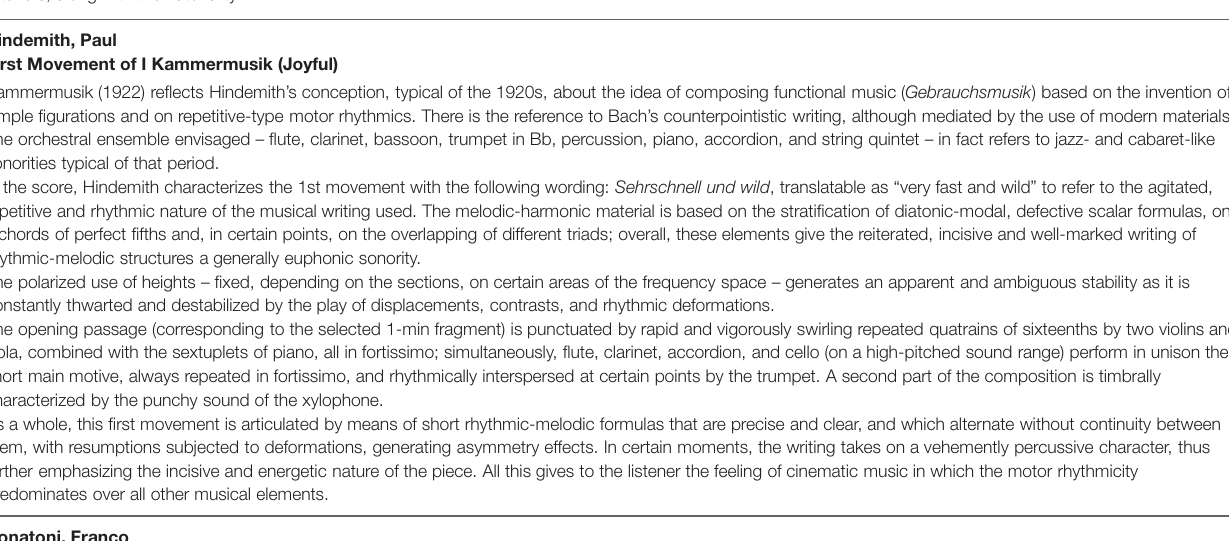
TABLE 2 | Musicological characterization of atonal pieces used in the psychophysiological study. Aside from their being associated with a specific emotional state (i.e., joy, agitation and pathos, respectively) they shared some properties (described below), such as their ability to induce anxiety and psychological tension in listeners, along with their